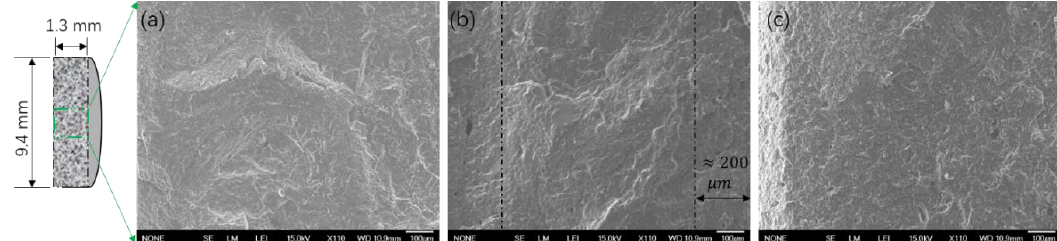
Figure 6. Scanning electron microscope (SEM) images of a cross-sectional surface from a PHS_UP blends tablet ( a ) before release, ( b ) at 72 h, and ( c ) at 588 h in water of 25 °C.